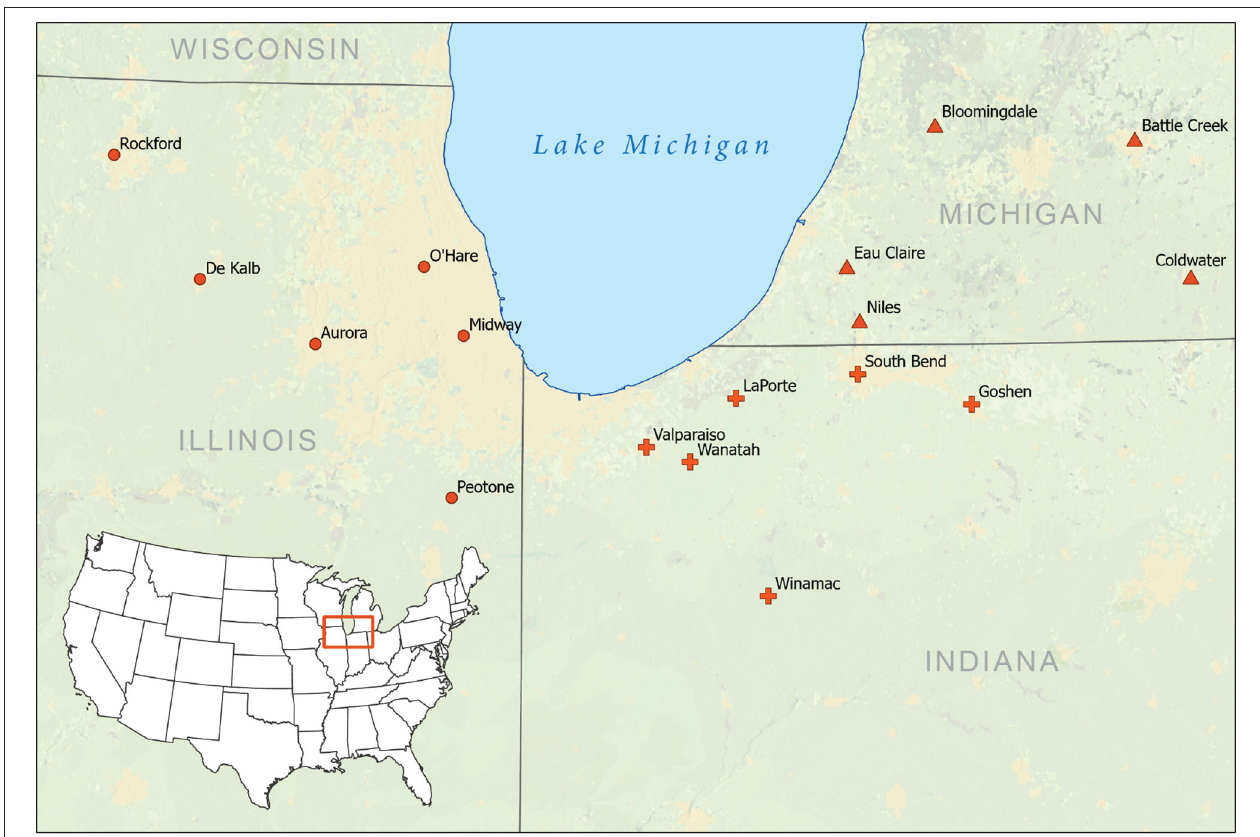
FIGURE 1 | Map of stations included in the analysis of lake-effect snowfall along the southern shore of Lake Michigan. Dots, pluses, and triangles denote stations in IL, IN, and MI,